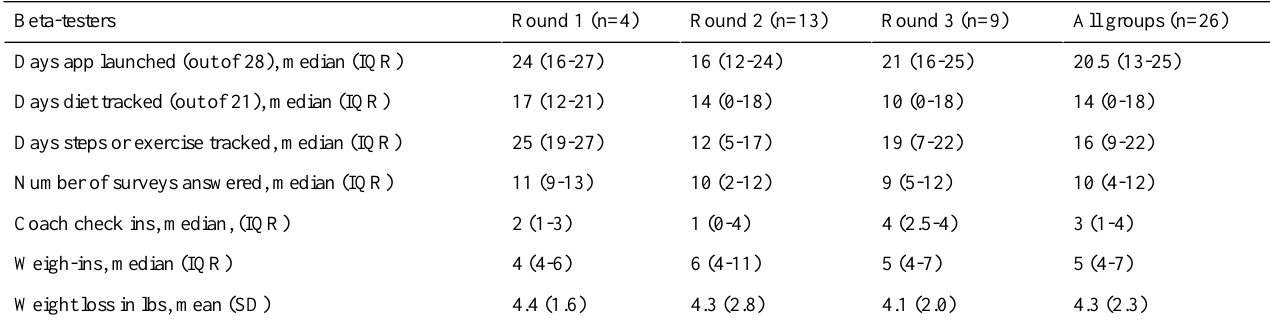
Table 2. User data for three rounds of beta-testing of the mobile health Fit After Baby